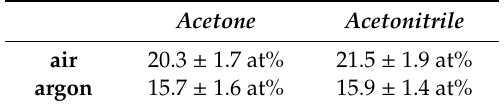
Table 2. Oxide fractions extracted from the Mössbauer spectra (fraction of Fe-atoms in the oxide